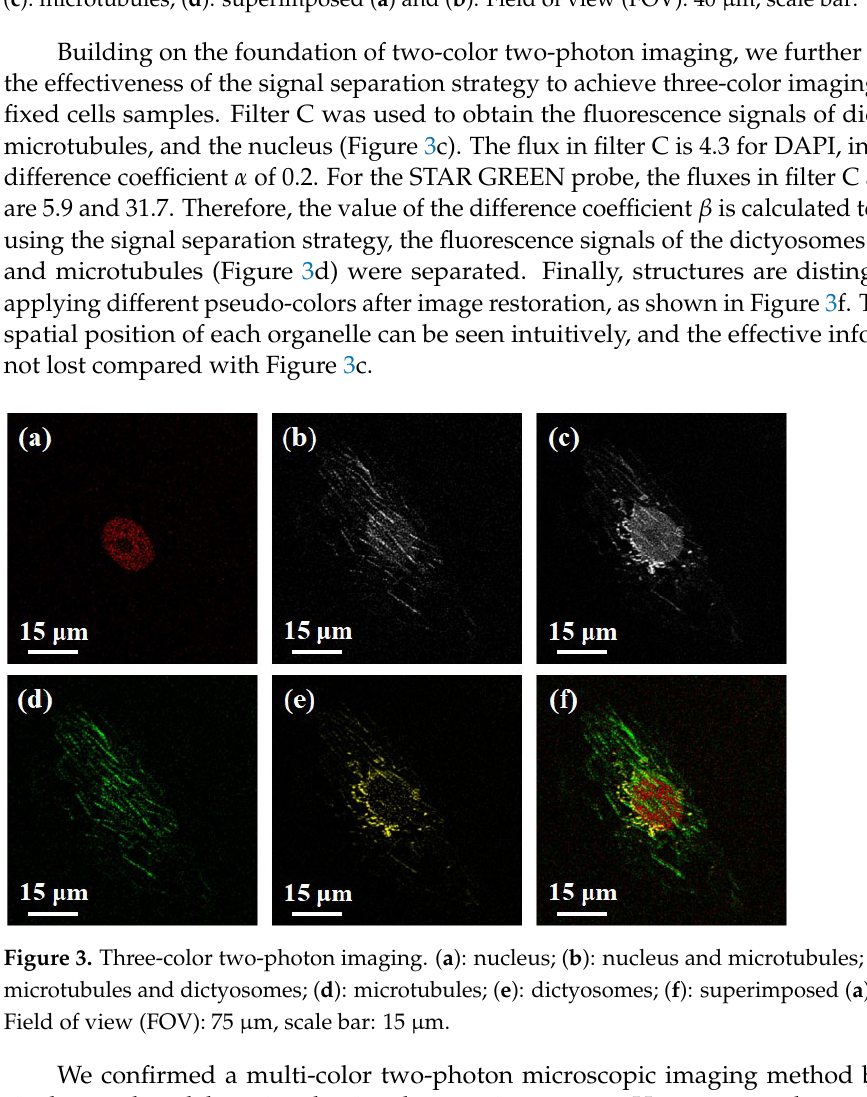
Figure 2. Two-color two-photon microscopic imaging.( a ): nucleus; ( b ): nucleus and microtubules; ( c ): microtubules; ( d ): superimposed ( a ) and ( b ). Field of view (FOV): 40 μm, scale bar: 10 μm.